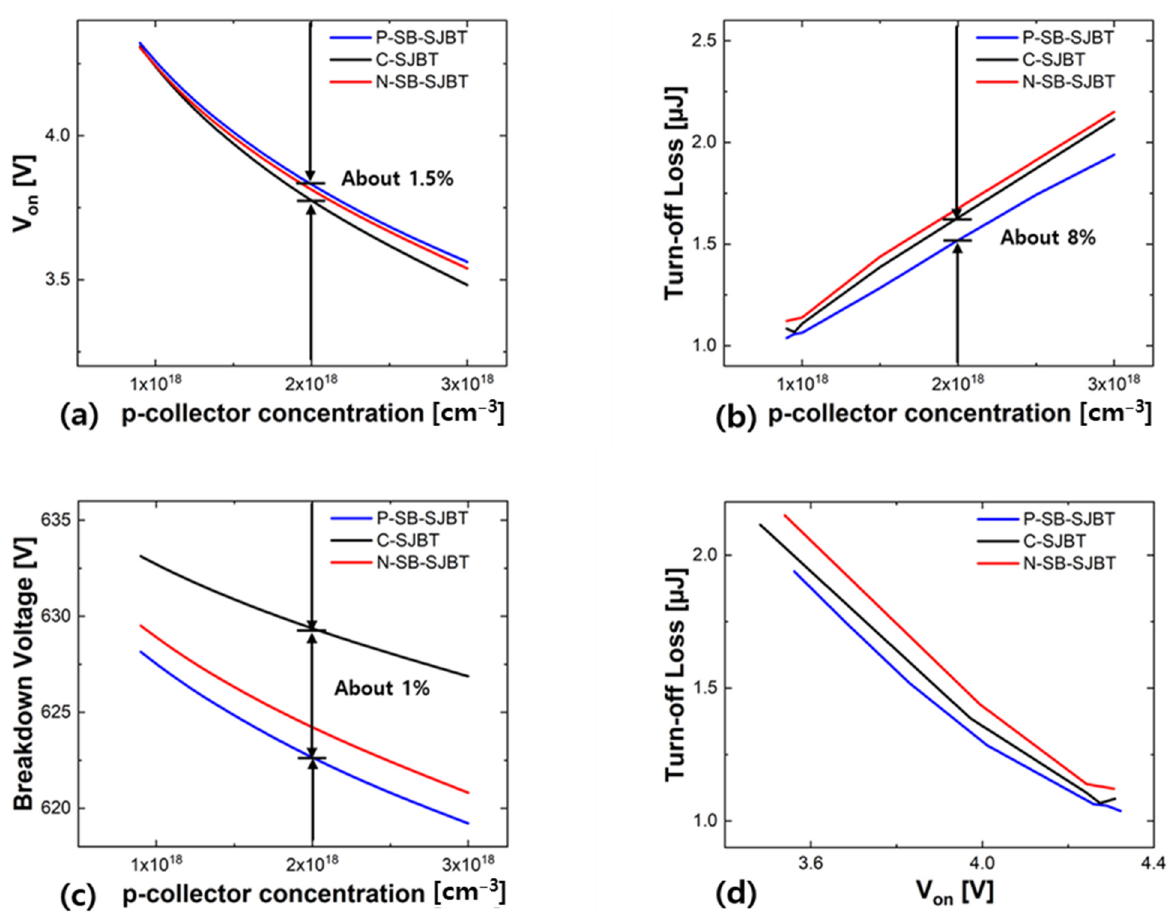
Figure 9. Result characteristics in this study. Even if the doping concentration of the p-collector is set to 2 × 10 18 cm − 3 , the increase in ( a ) V on is only about 1.5%, while the decrease in ( c ) BV is only about 1% but decrease in ( b ) E off is about 8%. The proposed structure (P-SB-SJBT) has the advantage of E off with similar V on and BV. ( d ) This is consistent with the excellent trade-off characteristics of the proposed structure. Simulation is measured under the same conditions, such as temperature (300 K).